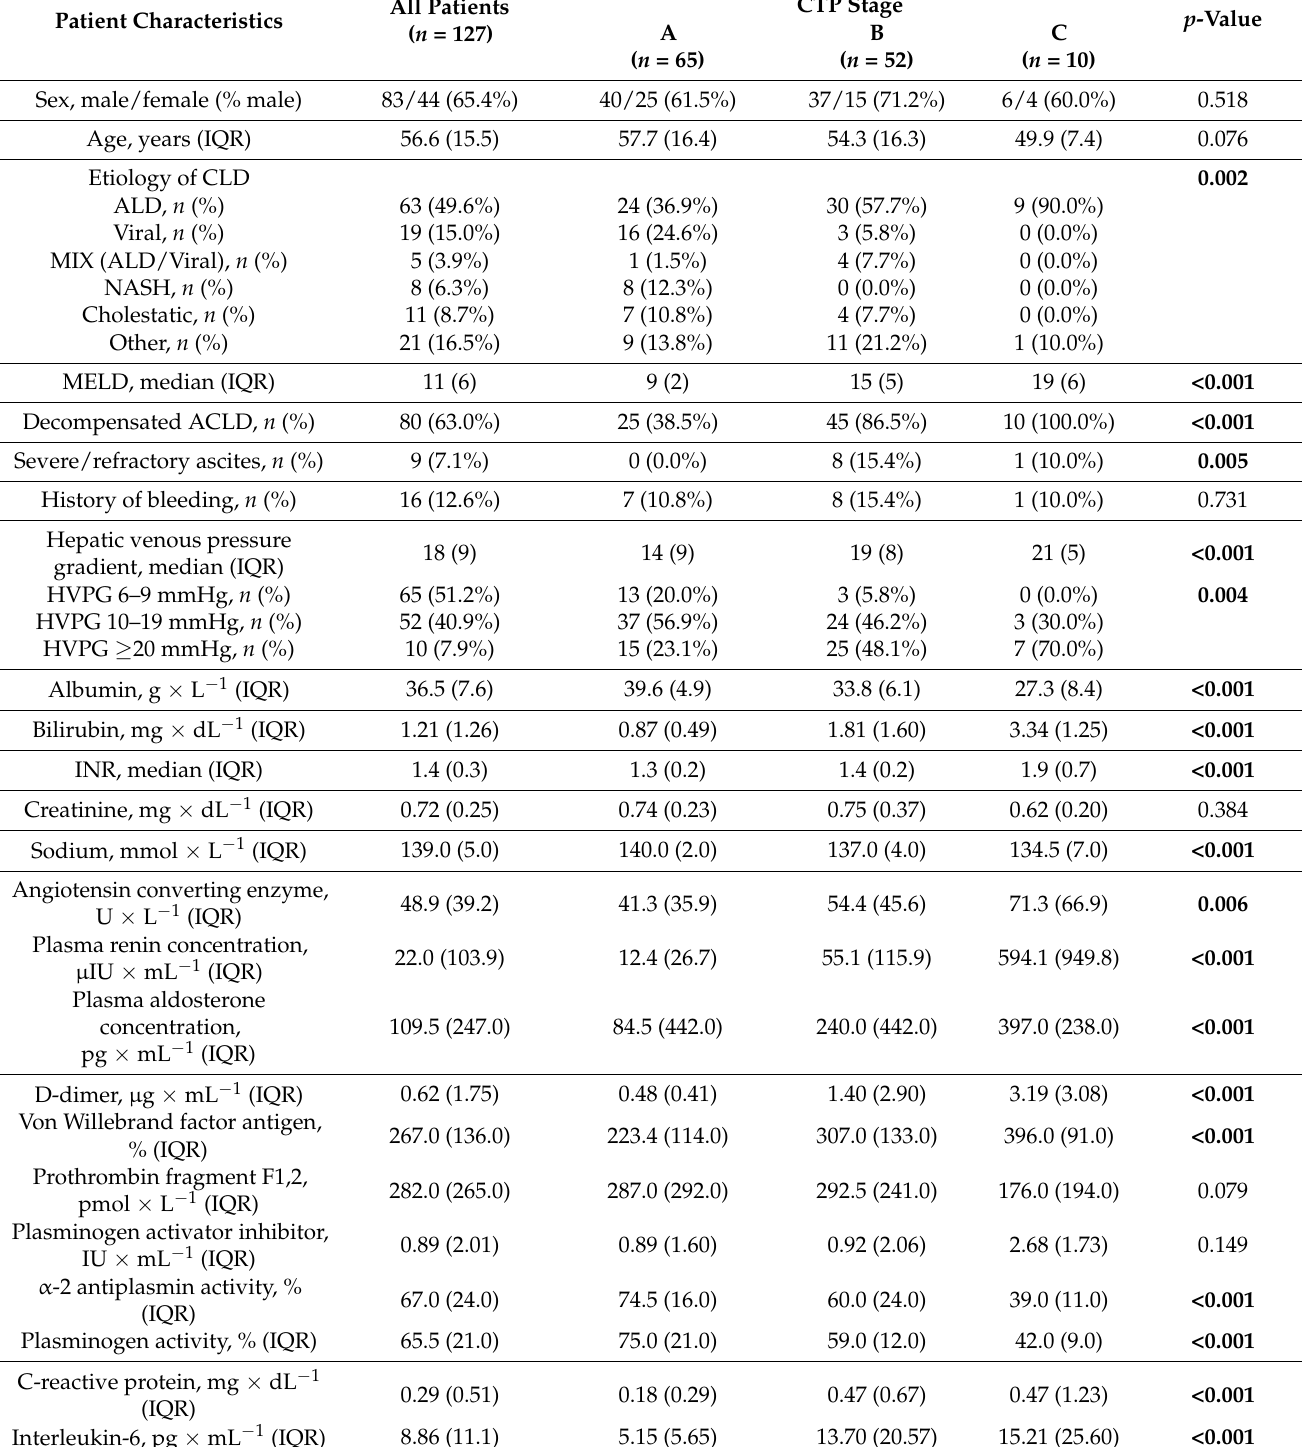
Table 1. Patient characteristics of cirrhotic patients (CIRR) and comparison between CTP